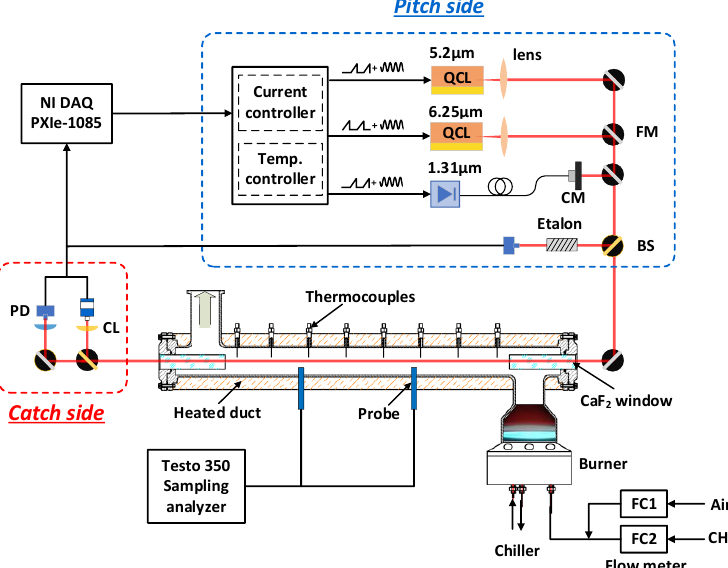
scanning sawtooth signal superimposed on a 50 kHz sinusoidal modulation signal gener- ated by the National Instruments DAQ system. The three laser beams were combined us- ing flipped mirrors.